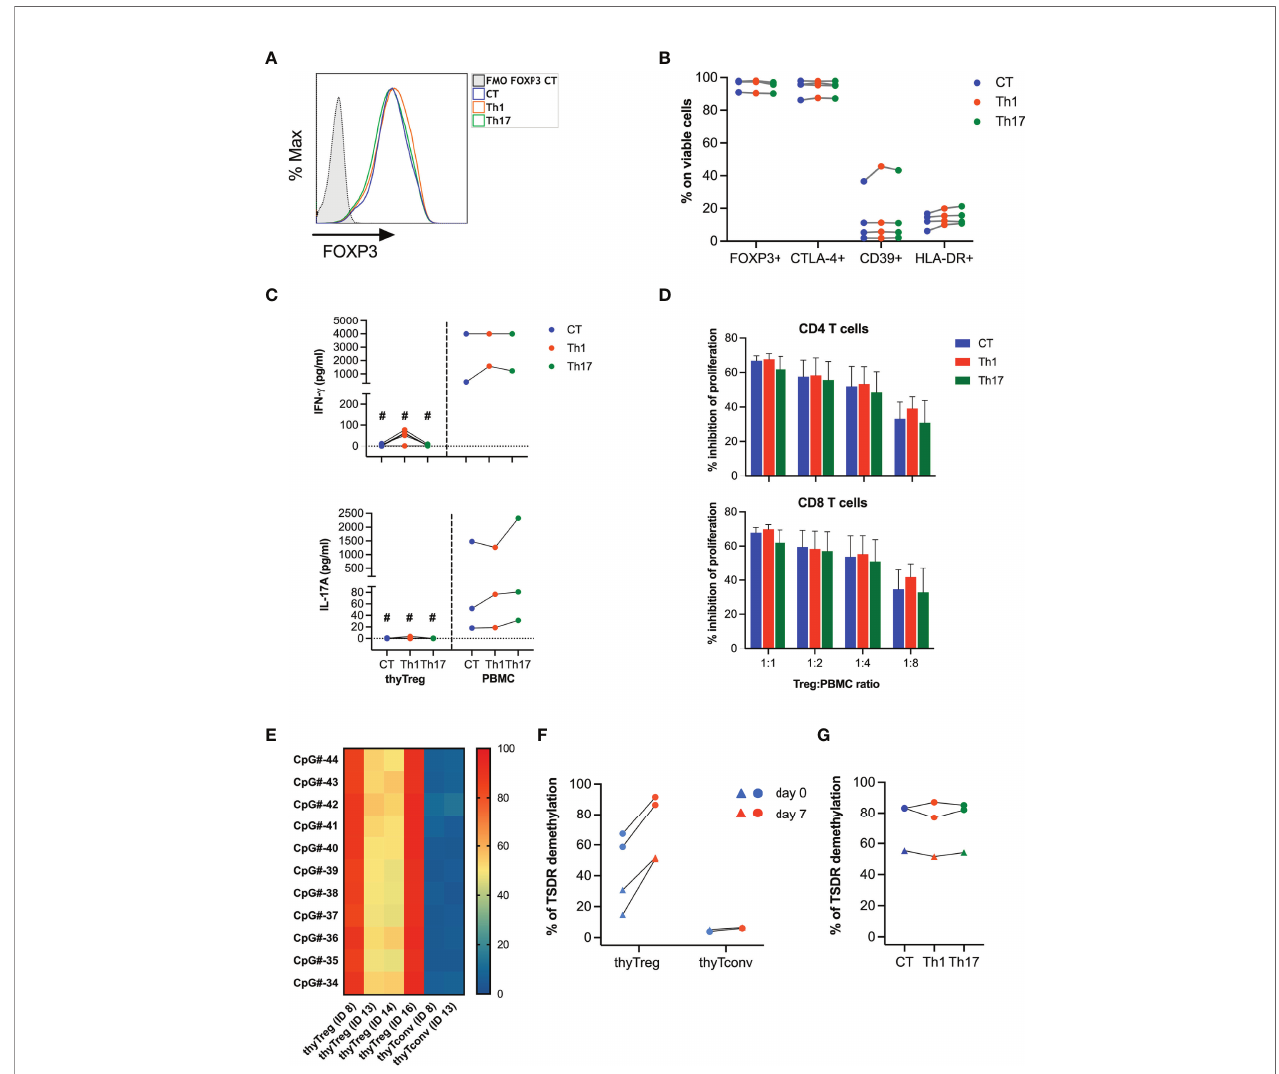
FIGURE 3 | Stability of thyTreg cell product. (A – D, G) thyTreg cell product was restimulated under control conditions (CT, blue), or under Th1 (orange) or Th17 (green) polarizing conditions and evaluated after 3 days of culture. PBMC were cultured in parallel under the same conditions. (A) Representative fl ow cytometry histogram showing FOXP3 expression. To determine the background signal, the fl uorescence minus one (FMO) of FOXP3 is shown. (B) Frequency of FOXP3, CTLA-4, CD39 and HLA-DR within thyTreg under different culture conditions. Paired Wilcoxon test showed no signi fi cant differences between conditions. (C) Quantitation of secreted IFN- g and IL-17A by thyTreg or PBMC under different culture conditions. Comparison between culture conditions within the same cell type was performed using paired Wilcoxon test, and comparison within the same condition between thyTreg and PBMC were performed using unpaired Mann-Whitney test ( # P < 0.05). (D) Summary (n=4) of the suppressive capacity of thyTreg cells cultured under different polarizing conditions de fi ned as % inhibition of CD4 (upper panel) and CD8 T (lower panel) cell proliferation at the indicated ratios. Graphs show mean ± SEM. Paired Wilcoxon test showed no signi fi cant differences between conditions. (E) Demethylation level of 11 conserved CpGs at the TSDR region of FOXP3 in n=4 thyTreg cell products and n=2 thyTconv cultured in parallel for 7 days. ID13 and ID14 are female donors. (F) Global TSDR demethylation level (calculated as the mean of demethylation of the 11 CpGs) of thyTreg and ThyTconv right after cell isolation (day 0, blue) or after 7 days of culture (day 7, orange). Triangles represent female donors, and circles represent male donors. (G) Global TSDR demethylation level of thyTreg cultured under different polarizing